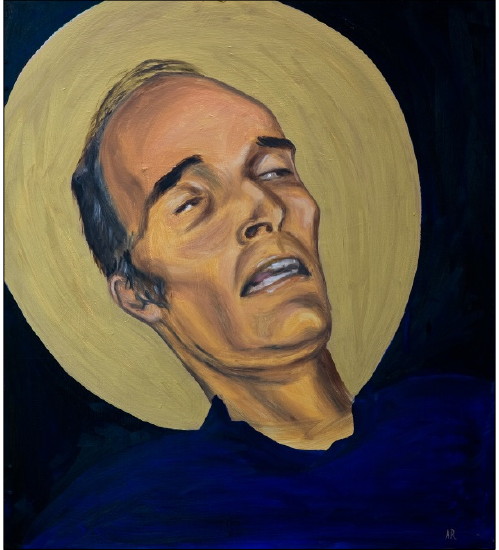
Figure 3. Steve as the Christ